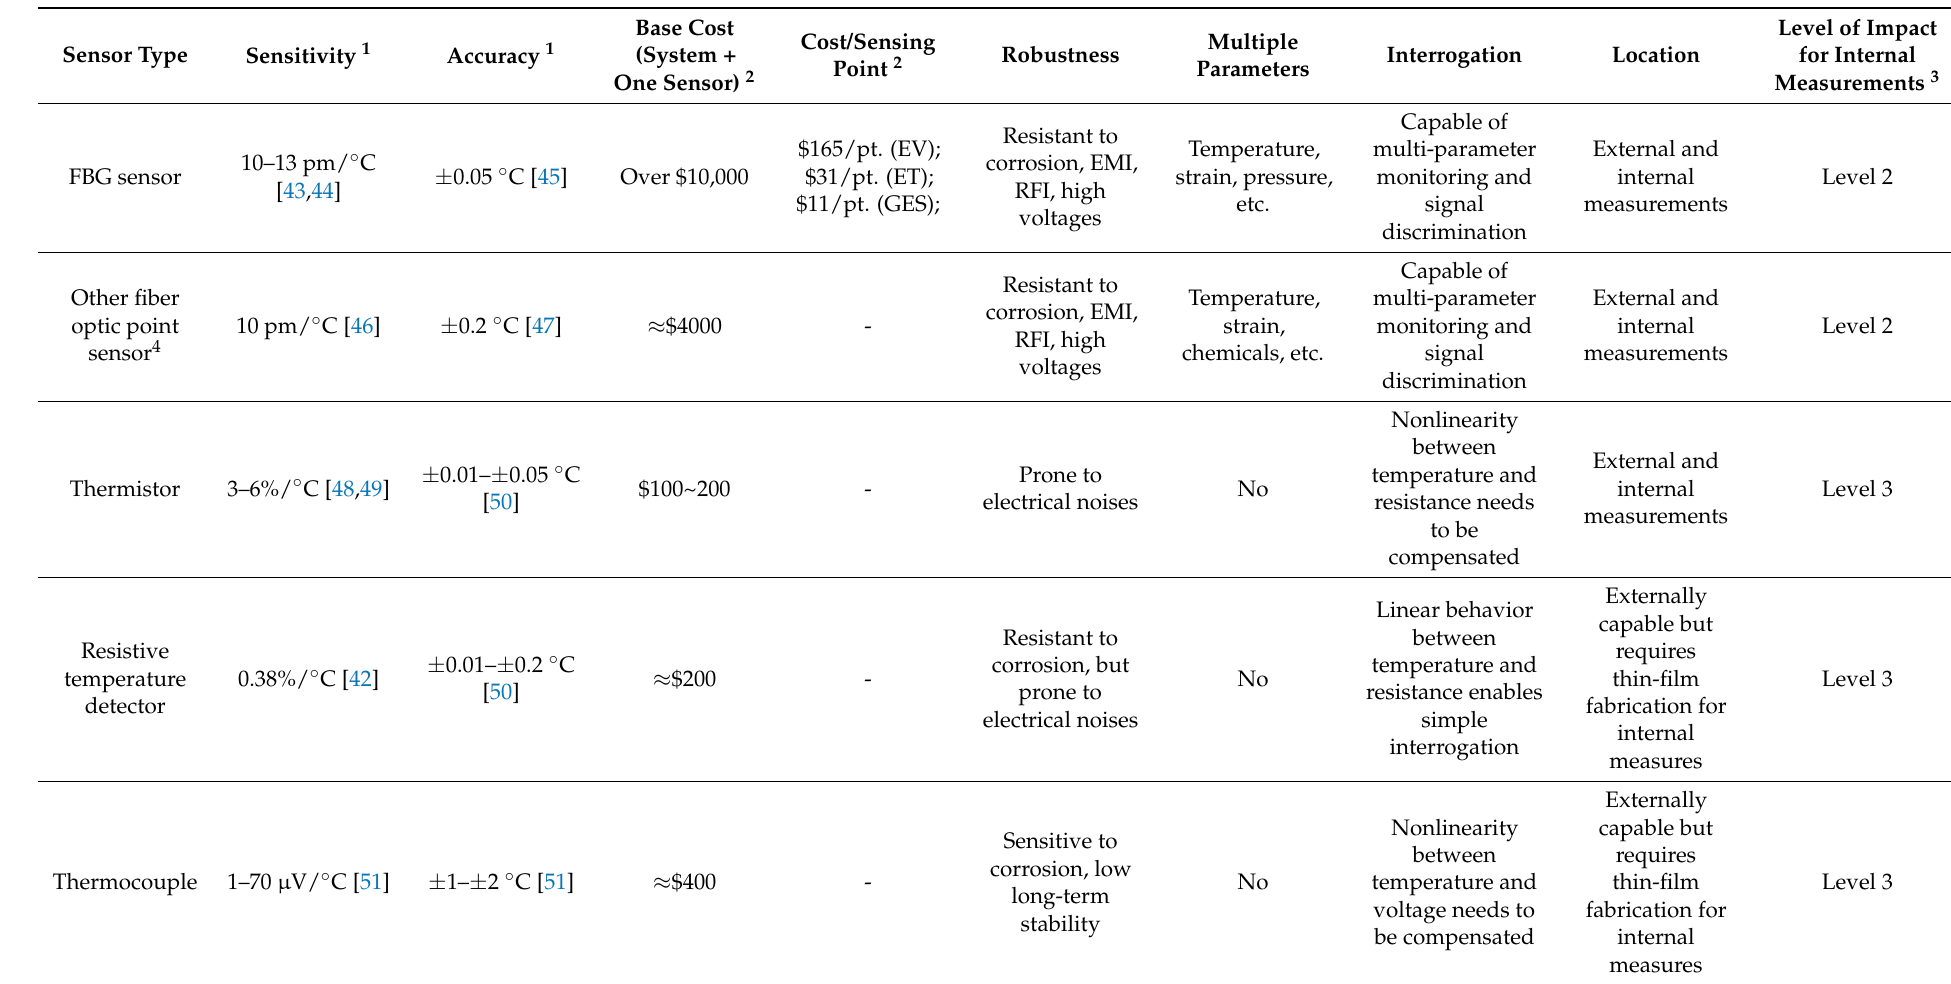
Table 2. Comparative criteria of commercialized fiber optic sensors relative to other temperature measurement methods for Li-ion